Question: In a single sentence, describe what this figure presents.
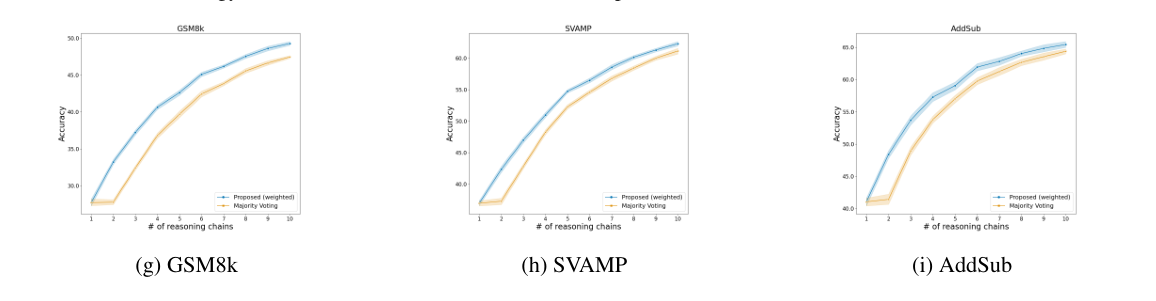
Answer: Self-consistency on the same reasoning chains, comparing between weighting the final answer using the scores from our proposed verifiers or taking the majority voting (↑). Overall, using the scores of our proposed verifiers to perform weighted voting consistently improves the final performance.